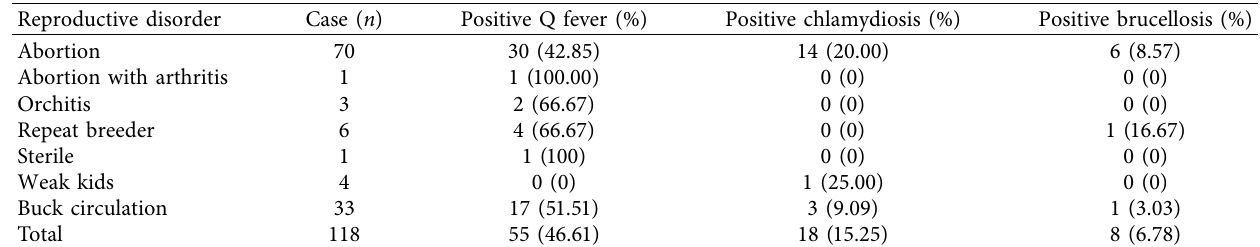
Table 1: Description of clinical reproductive disorders and bucks’ circulation related to seropositivity for Q fever, chlamydiosis, and brucellosis in 49 smallholder goat herds in northeastern Thailand. Reproductive disorder